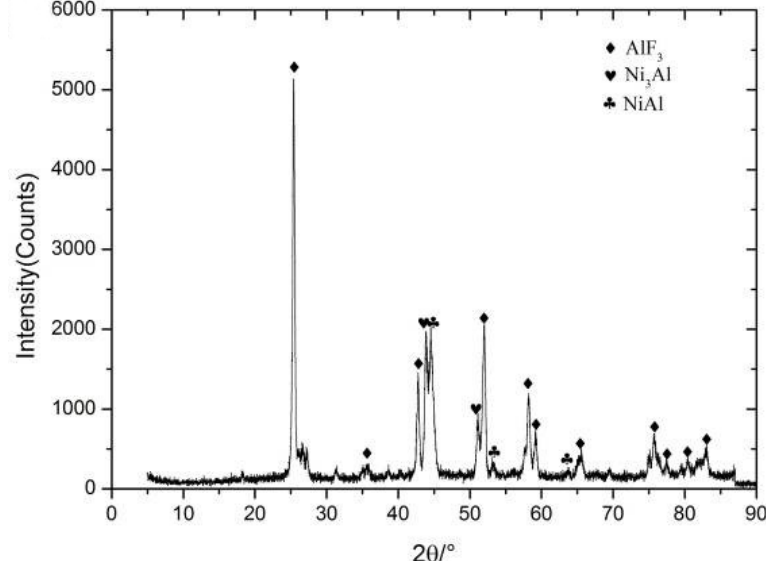
Figure 8. The X-ray diffraction result of the reaction residues of type C specimen after quasi-static